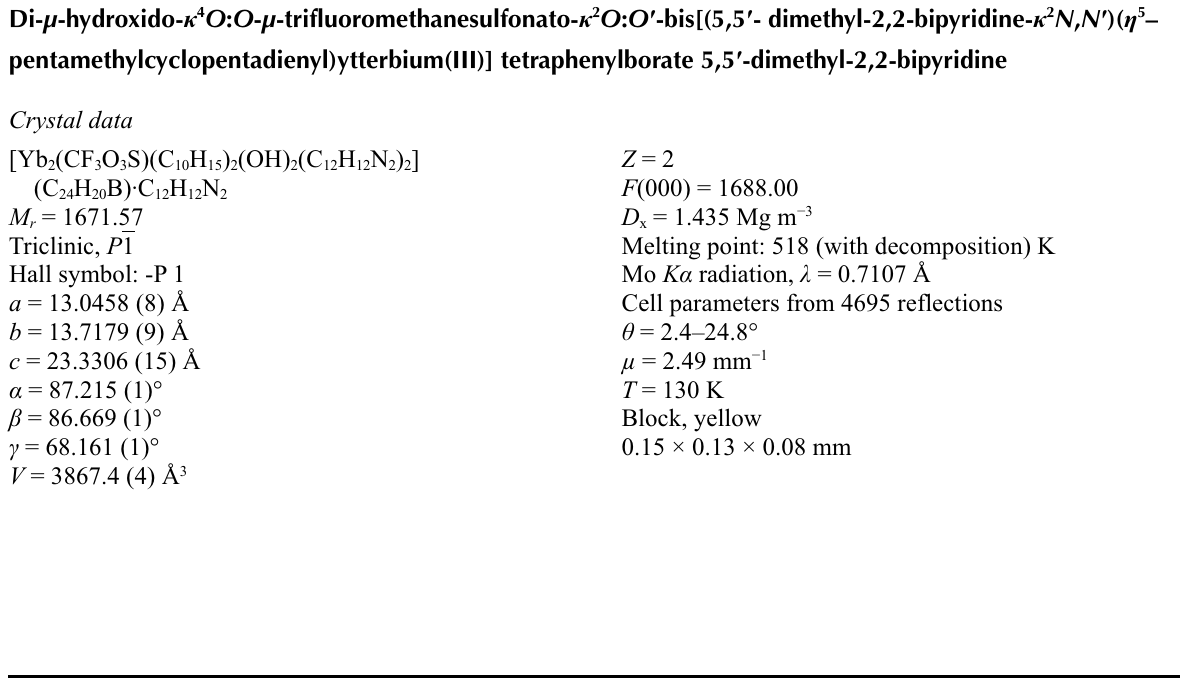
A view of the title compound with displacement ellipsoids drawn at the 50% probability level; hydrogen atoms have been omitted for